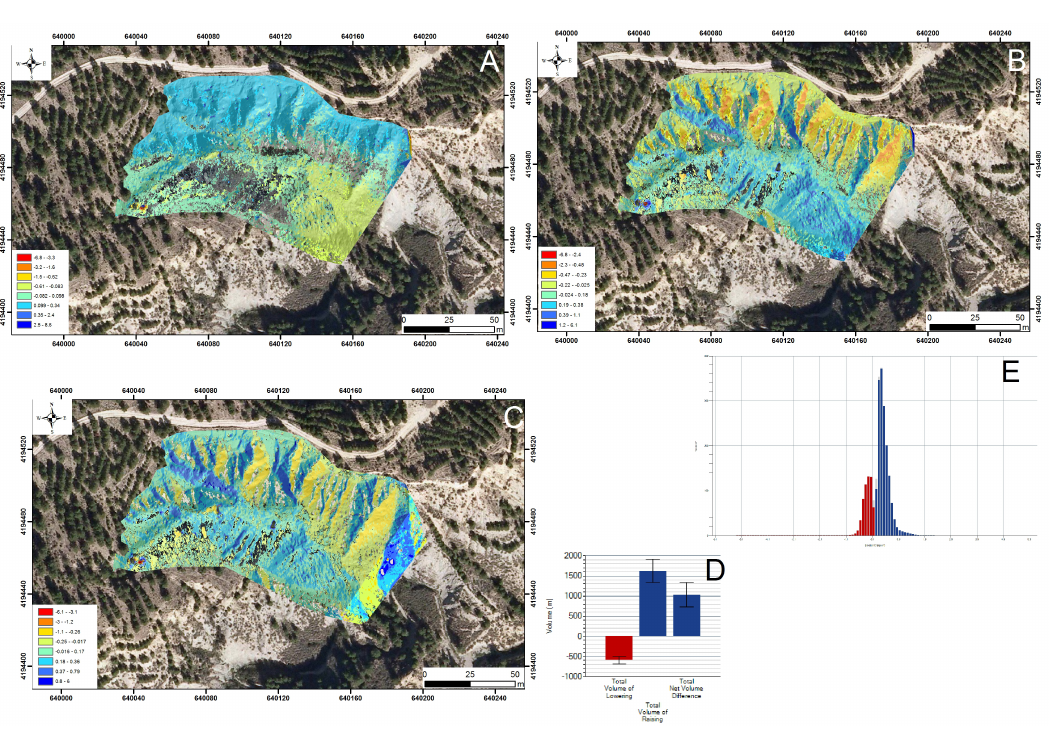
Figure 10. Bank gully (B.G-1)( A ) DoD Mission I and II. ( B ) DoD Mission II and III. ( C ) DoD Mission I and III. ( D ) Graphe of DoD volume. ( E ) Bar chart of DoD volume change distribution (erosion volume in red, deposition volume in